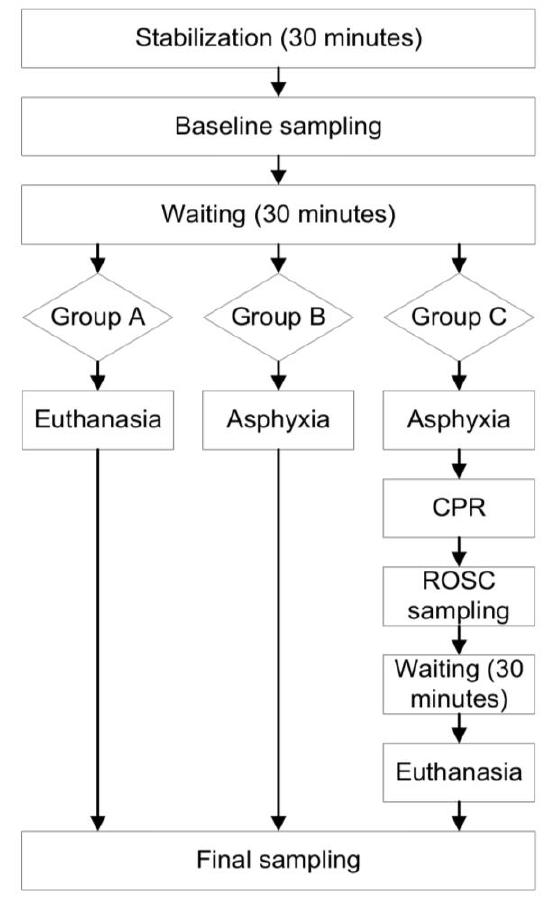
Figure 1. Flow chart of the study sampling and animal handling.